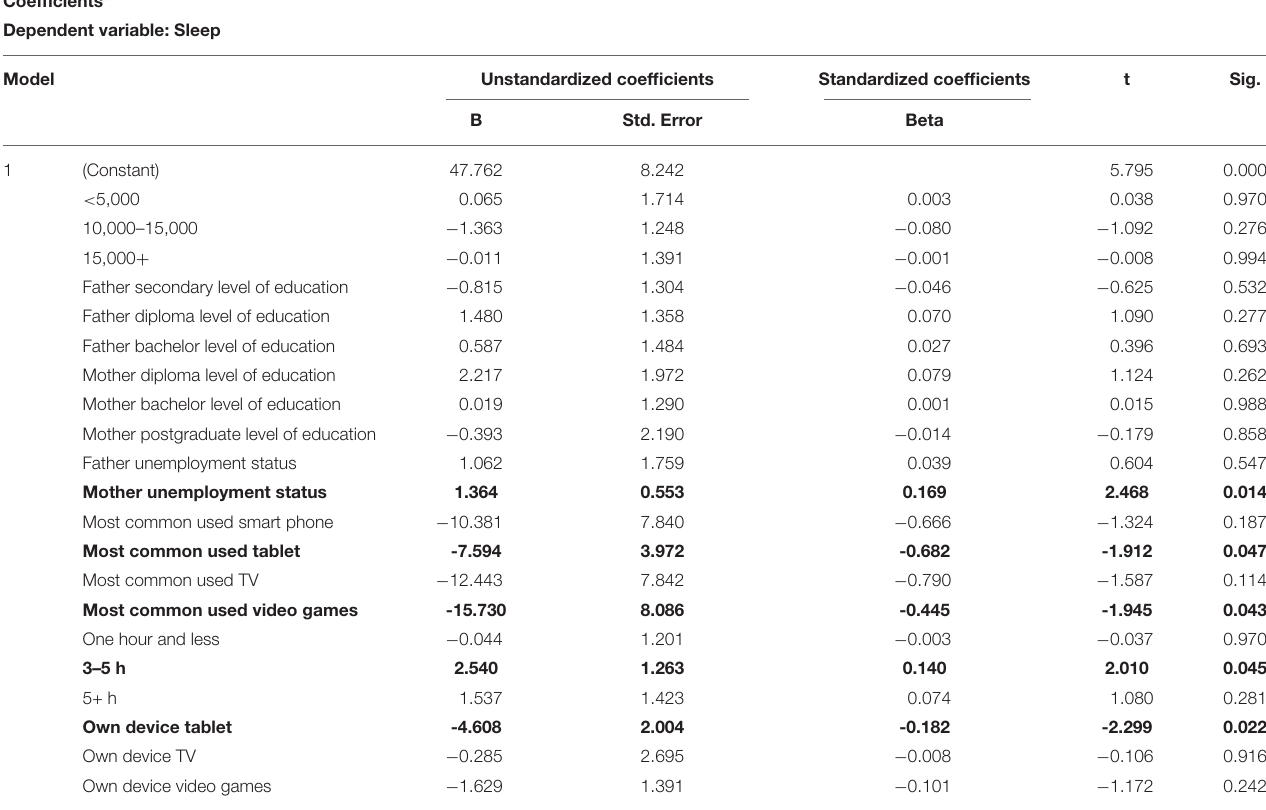
TABLE 9 | Regression coefficient table showing the strength of association between technology and demography variables and “Sleep Disturbance Scale for Children” scores. Coefficients a